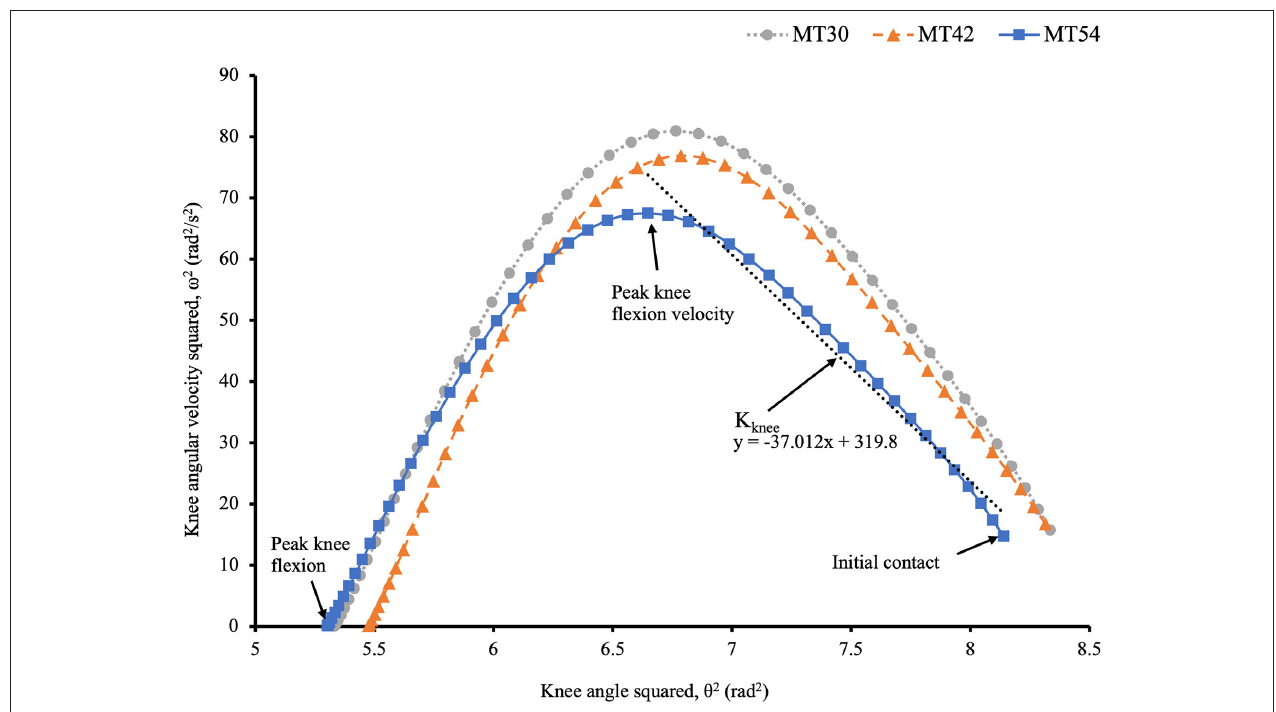
FIGURE 2 | The relationship between ω 2 and θ 2 of knee joint on a typical subject trial between shoe conditions during the first half of stance. Notice the two distinct sub-phases with the upward part of the curve from IC representing the impact phase and the downward part represents a weight acceptance phase (not covered in this paper). 1 (cid:0) ω 2 (cid:1) /1 (cid:0) θ 2 (cid:1) for knee joint stiffness calculation was determined as the slope of the regression line shown above (i.e., the coefficient of the regression equation) throughout 20–80% of the data points (the most linear portion) of the impact